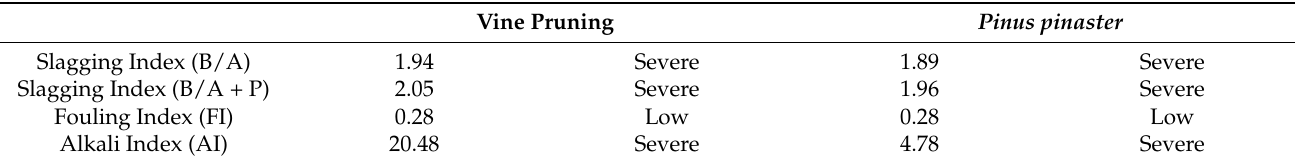
Table 12. The Fouling and Slagging indexes for samples of vine pruning and Pinus pinaster .